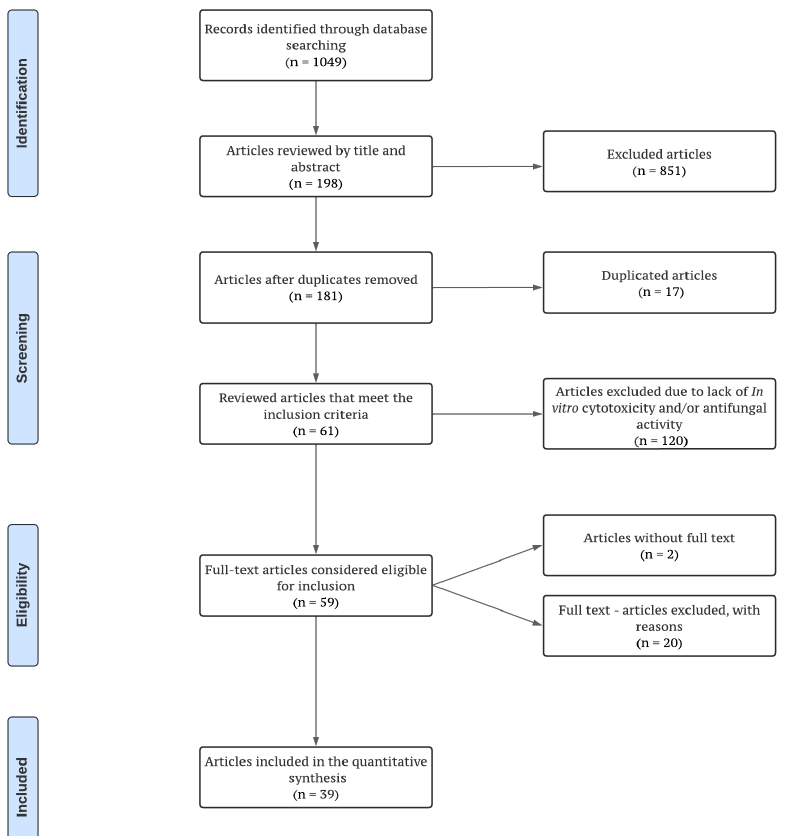
Figure 1. Screening and selection process flow chart, according to the PRISMA statement.